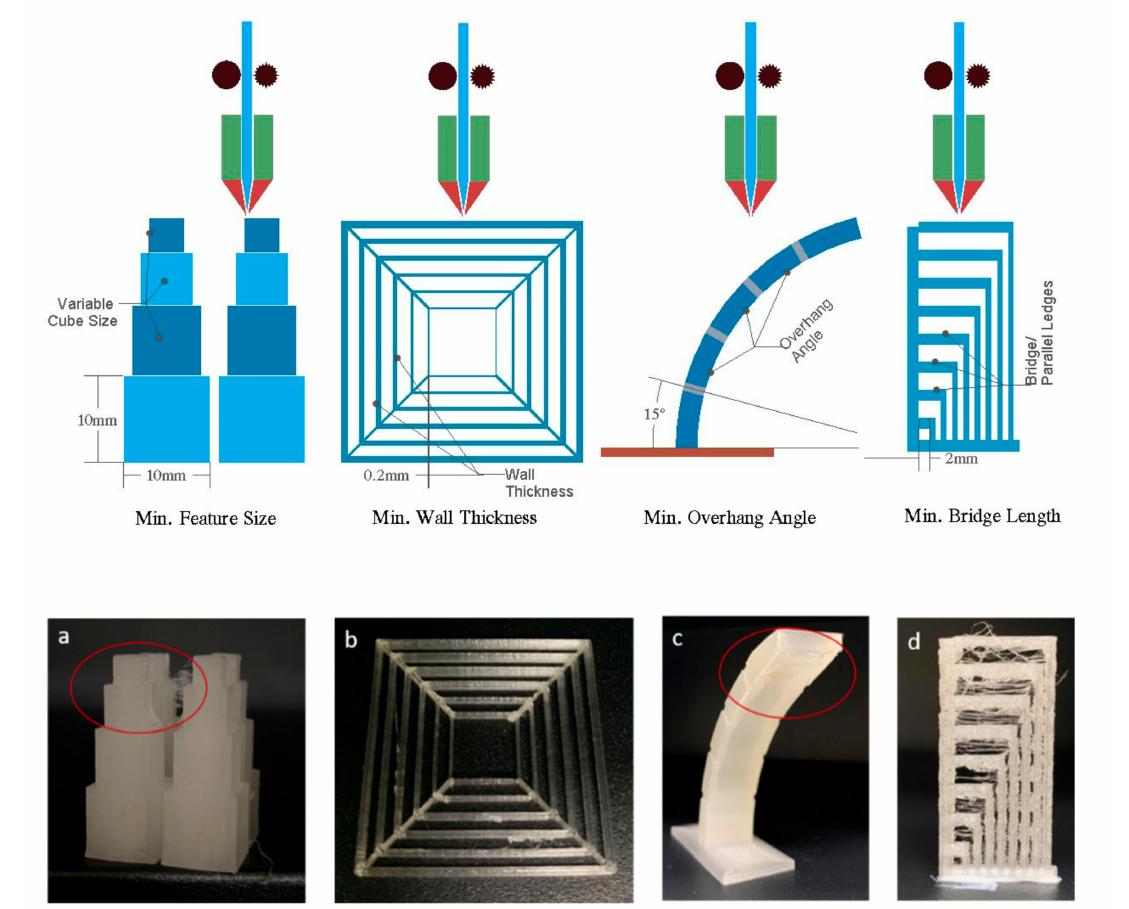
Figure 3. Four parameters considered within design for additive manufacturing and post-processing ( a ) minimum feature size ( b ) minimum wall thickness ( c ) minimum overhang angle ( d ) minimum bridge length.